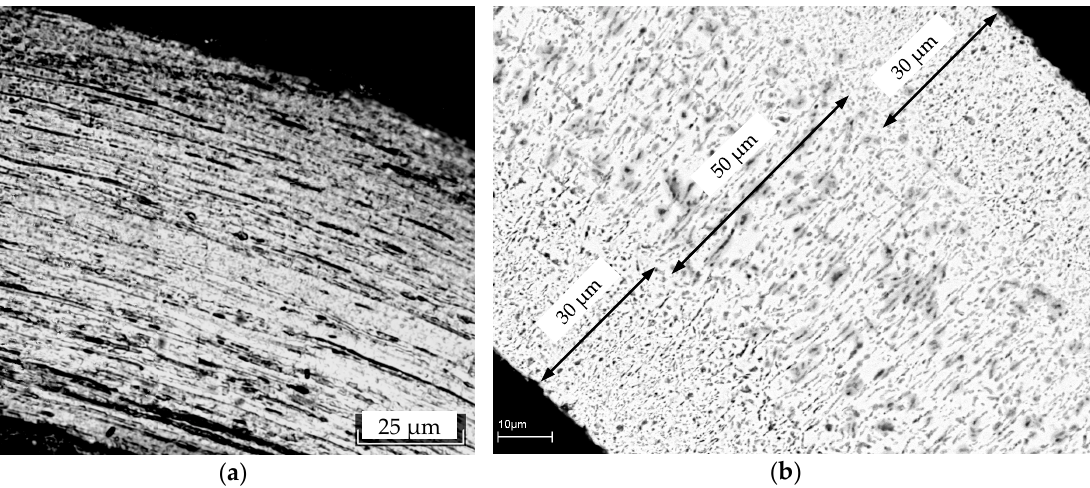
Figure 5. Microimages of a goffered molybdenum plate cross ‐ section: ( a ) an original substrate after cross ‐ section preparation and its etching; ( b ) after electrolysis.